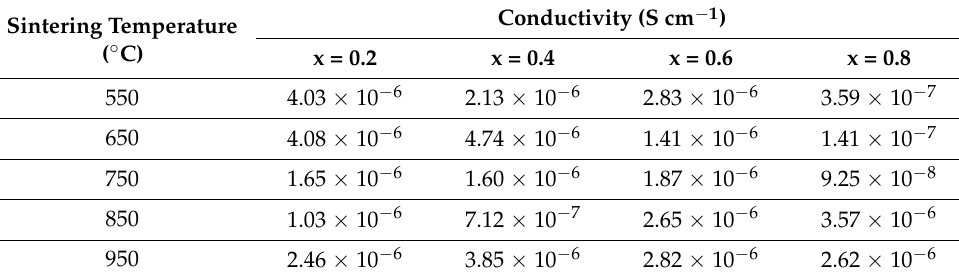
Table 2. Conductivity values for all samples at different sintering